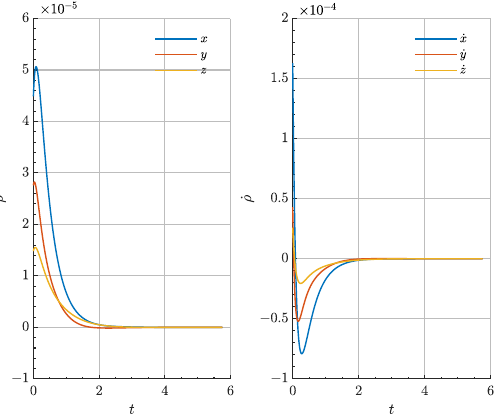
Figure 14. Evolution of the relative state vector components for the JWST servicing spacecraft during the low-thrust approach.